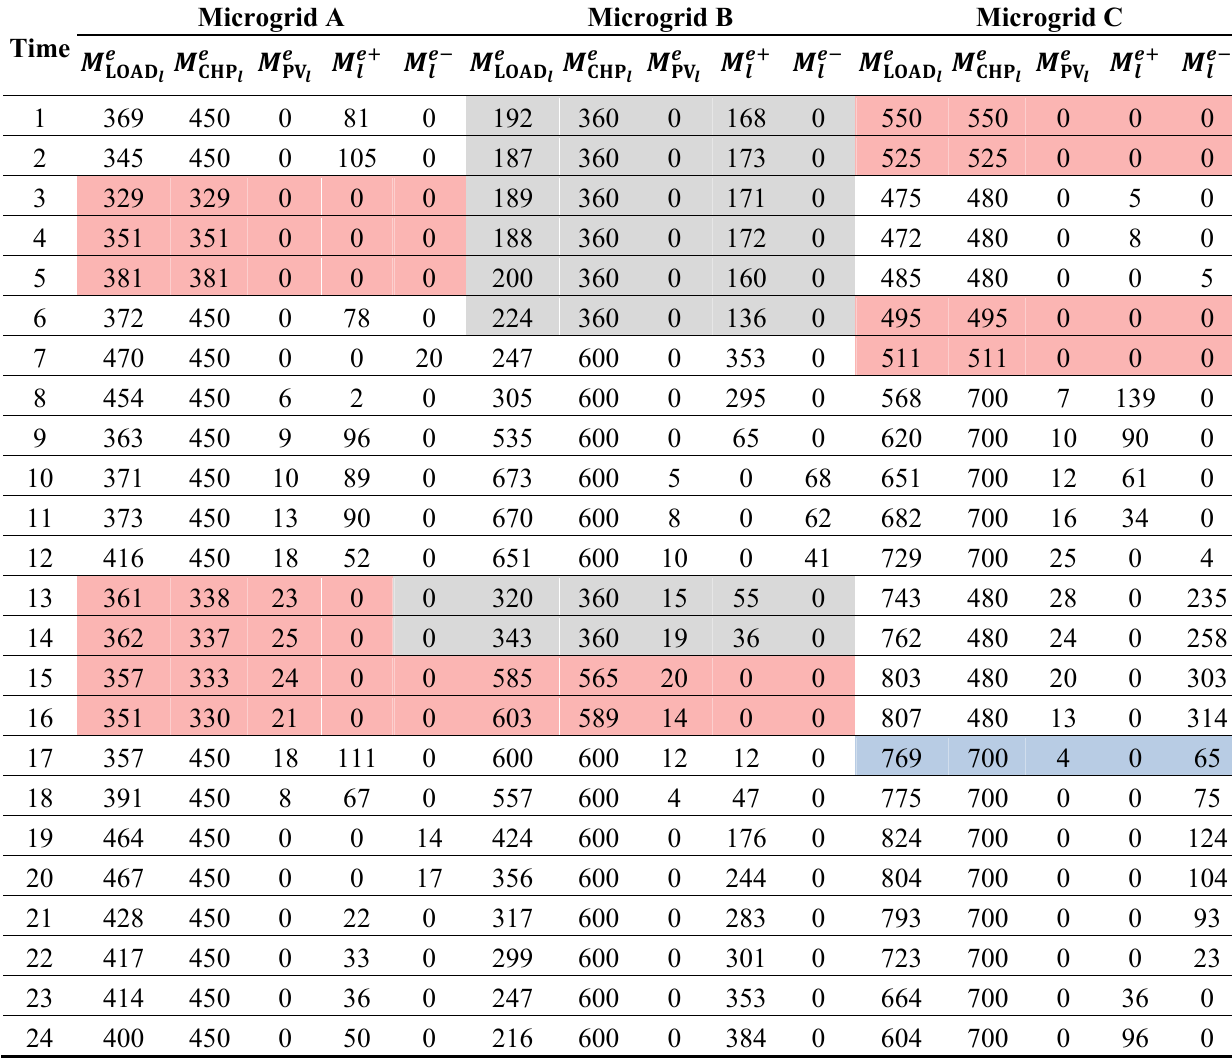
Table 1. Optimal local operation results from Step